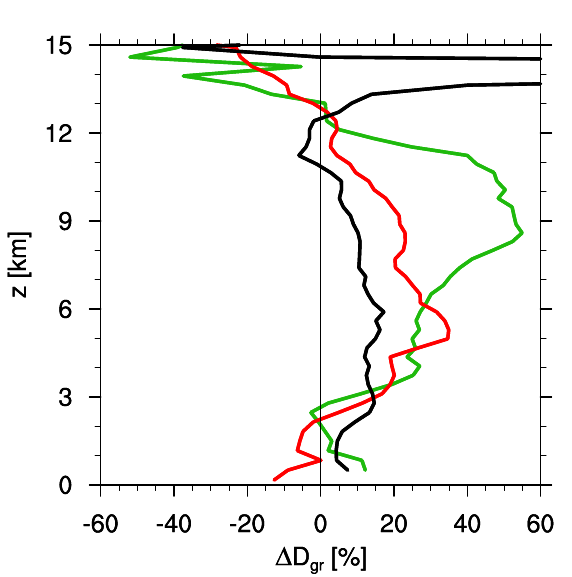
Fig. 5. Change in the domain-averaged total condensed water path (“Polluted” minus “Clean”) as a function of time ( t ) for the bin (green), bulk-explicit (black), and bulk-original (red) model config- urations.